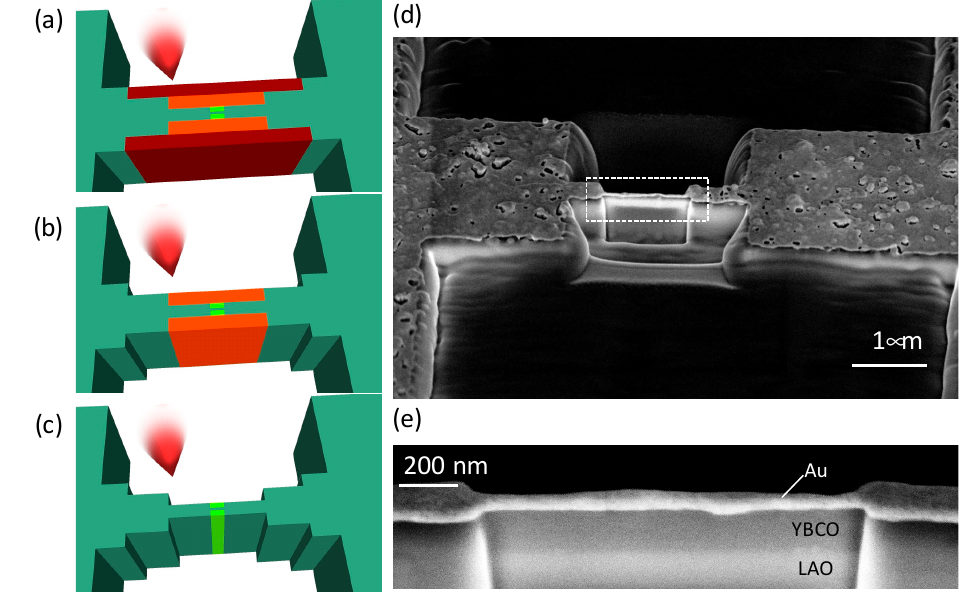
Figure 1. ( a – c ) Schematic representation of the milling process used to fabricate the nanowires. Red, orange, and yellow colors represent milling doses of 200 pA, 50 pA, and 10 pA, respectively. ( d ) Tilted SEM image of an 80-nm wide nanowire. ( e ) Zoom-in image of the nanowire cross-section (region marked with dots in ( d )).